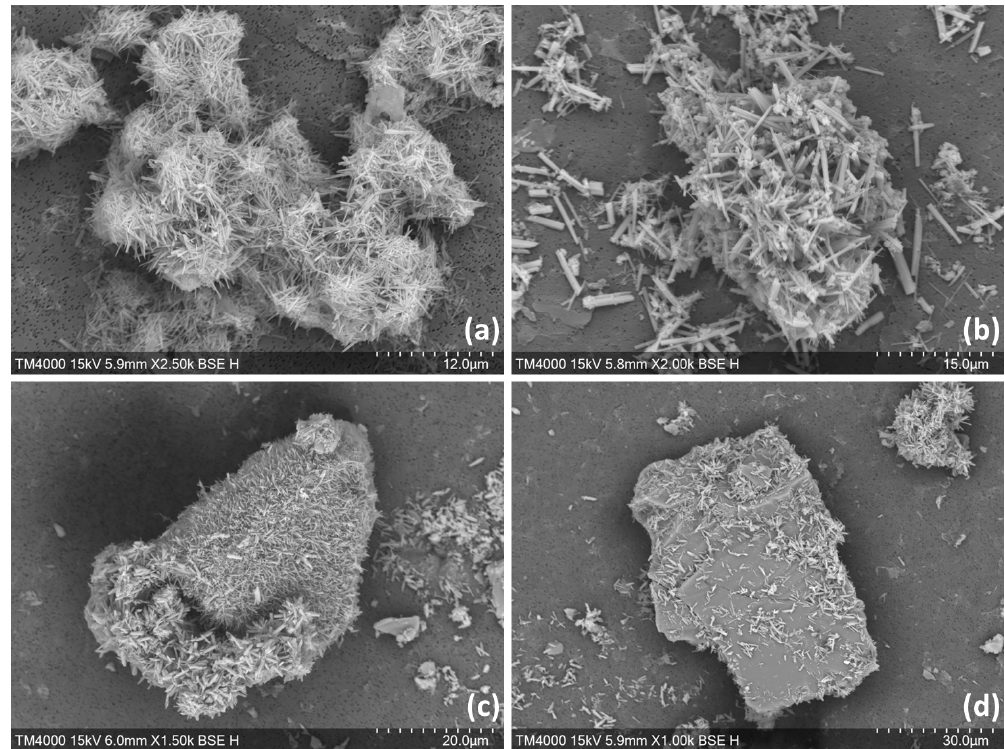
Figure 5. SEM images from experiments with an increase in TA of ∼ 500µmolkg − 1 by CaO (a) and Ca(OH) 2 (b) and with a TA increase of ∼ 1050µmolkg − 1 by 1M Na 2 CO 3 , followed by quartz particles addition ( c and d